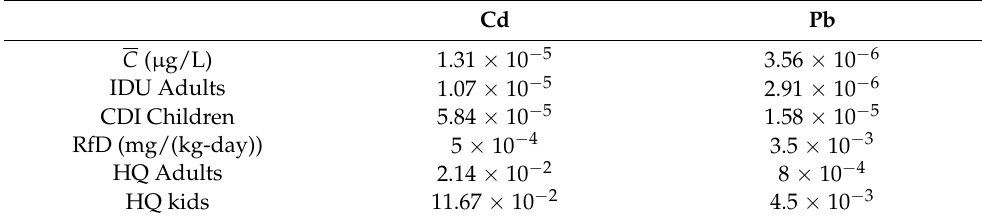
Table 1. Hazard quotients and total hazard index for heavy